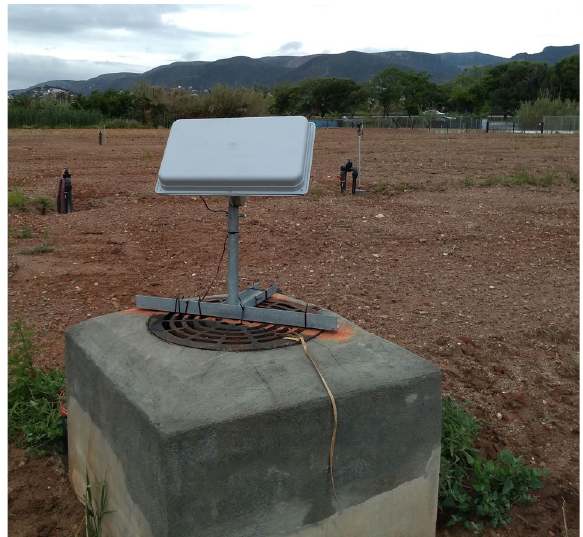
Figure 4. AR prototype installed in the campus of CTTC.